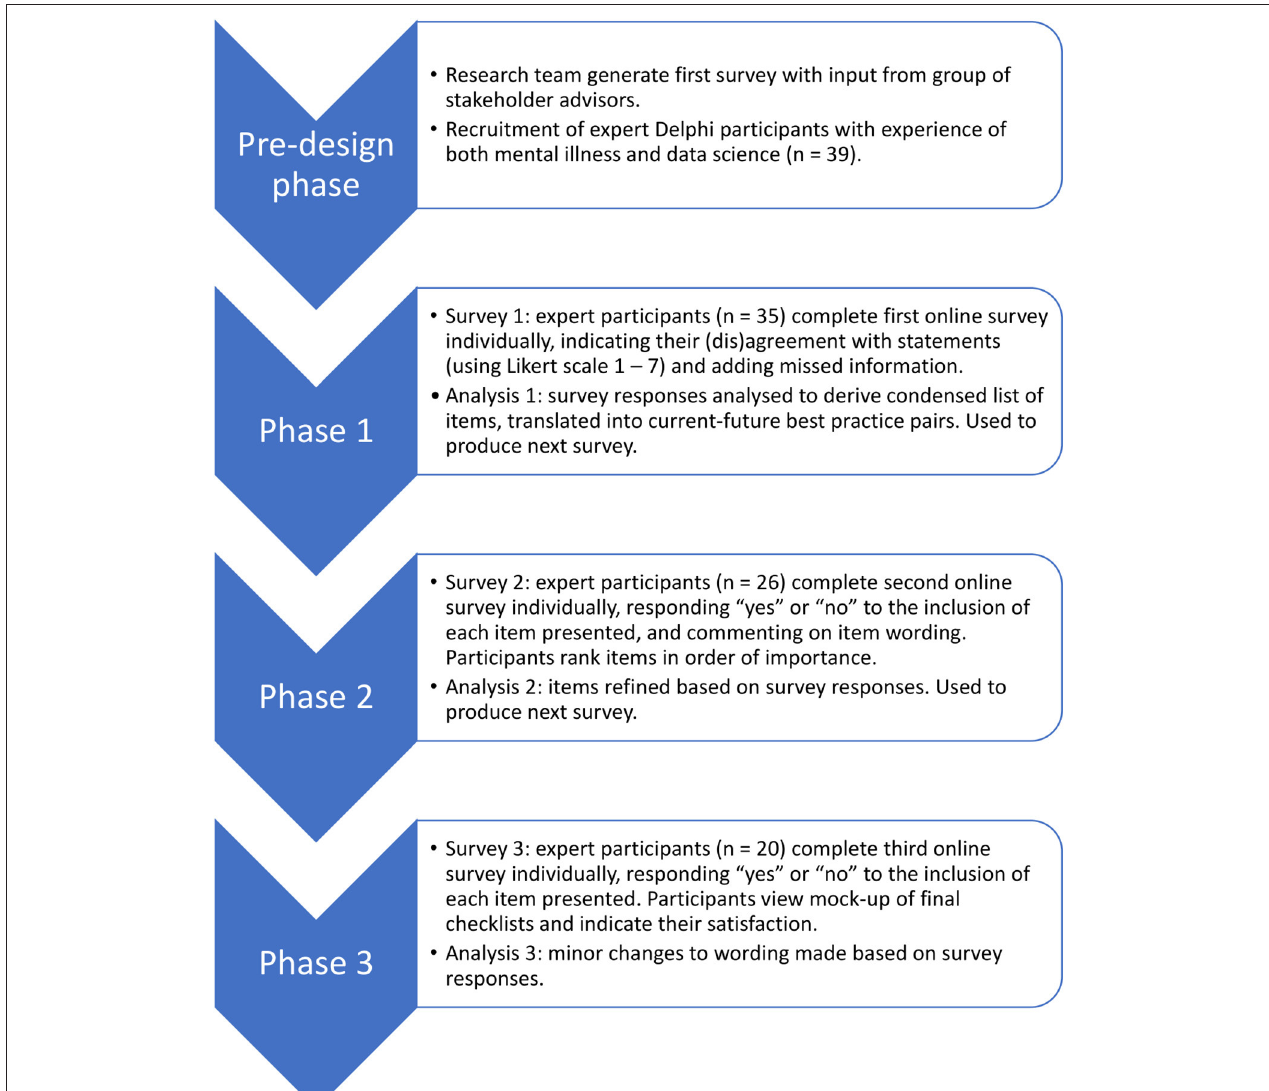
FIGURE 1 | Illustration of the phases of the Delphi